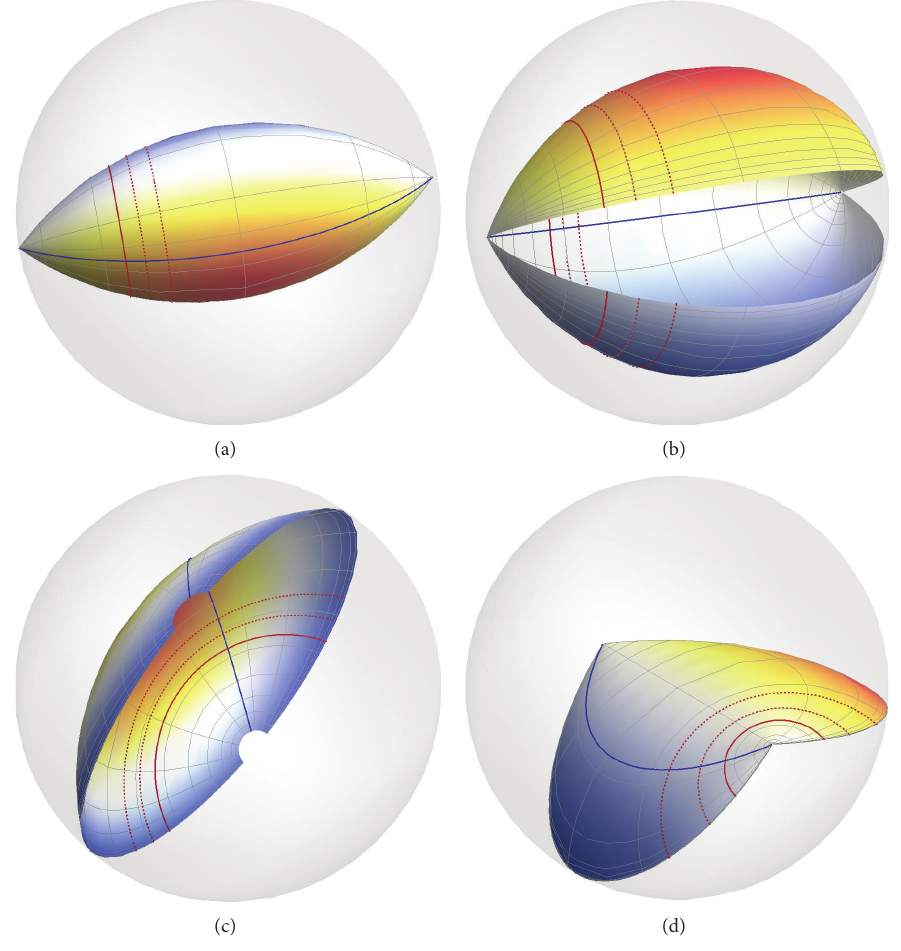
Figure 1: Examples of some 𝐺 1 -invariant